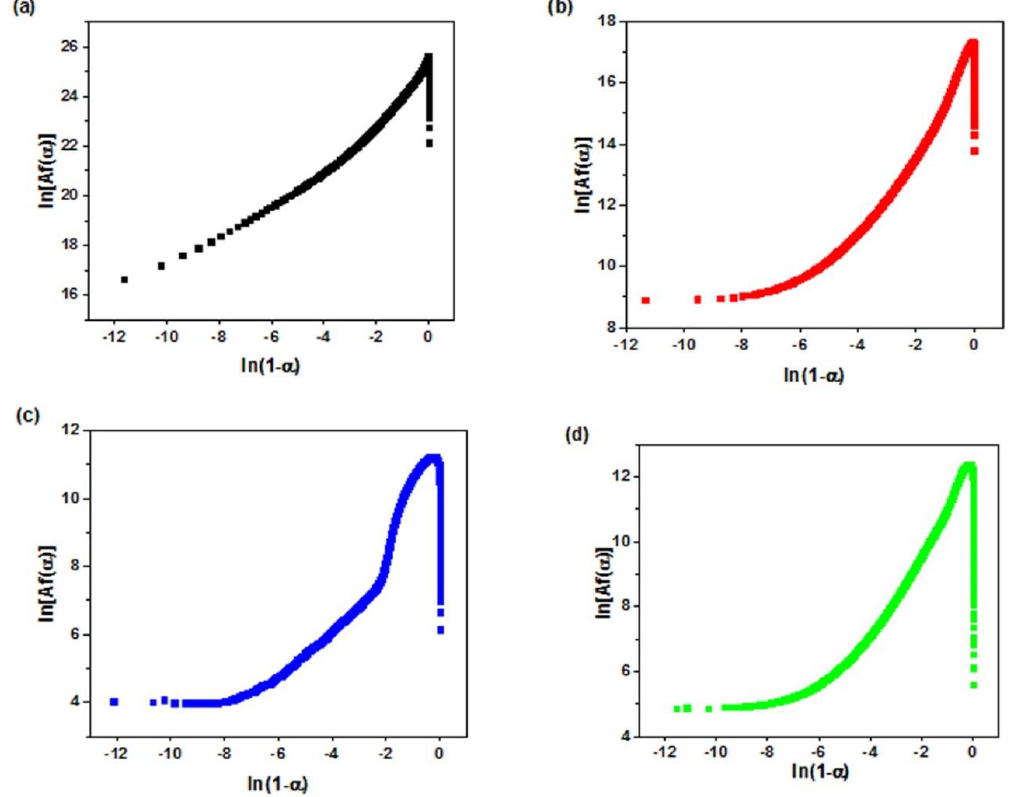
Figure 7. Plots of ln [Af( α )] vs. ln(1 − α ) for ( a ) neat epoxy, ( b ) epoxy / P-HNT, ( c ) epoxy / A-HNT and ( d ) epoxy / F-HNT.